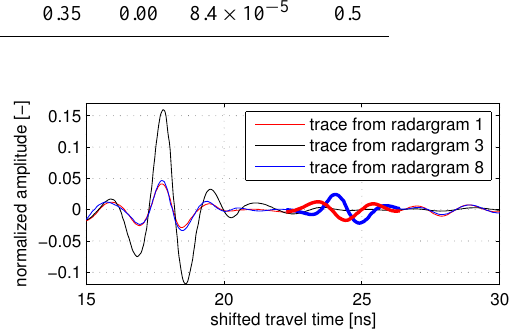
Figure 7. Detailed view of the compaction layer reflection. The traces shown have been averaged over the regions, which are marked by correspondingly colored rectangles in Fig. 6 (radar- grams 1, 3 and 8). The traces have been referenced to the central maximum feature of the first layer reflection (illustrated at travel times between 15 and 20ns). The respective compaction layer re- flection wavelets are drawn with thick lines where they can be dis- cerned (radargrams 1 and 8). For radargram 3 (water table coincides with the first layer reflection), the compaction layer does not yield a clearly discernible reflected wavelet due to the much smaller per- mittivity contrast in this fully saturated